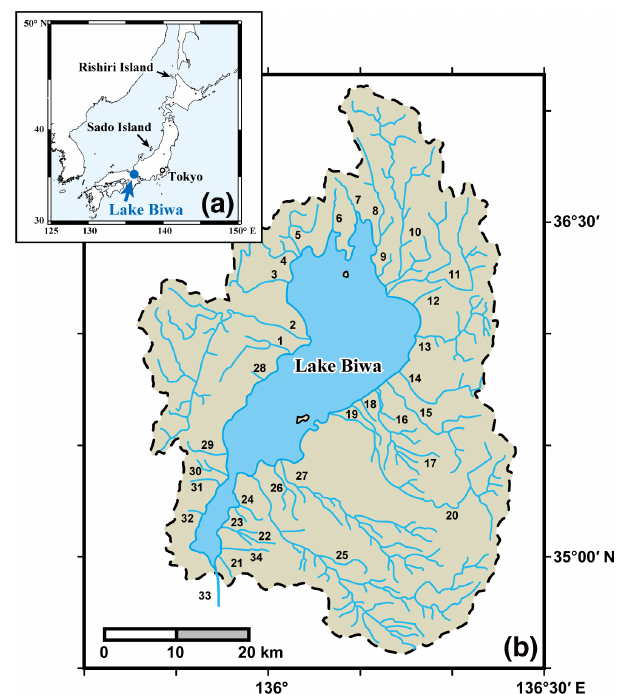
Figure 2. (a) Map showing the location of the Lake Biwa watershed basin in Japan and Sado Island, where the Sado-seki National Acid Rain Monitoring Station is located. (b) Map showing the boundary of the Lake Biwa watershed basin (dashed line) and the locations of the inflows (represented by numbers) and the outflow (Seta River, no. 33) studied in this paper (modified from Ohte et al.,